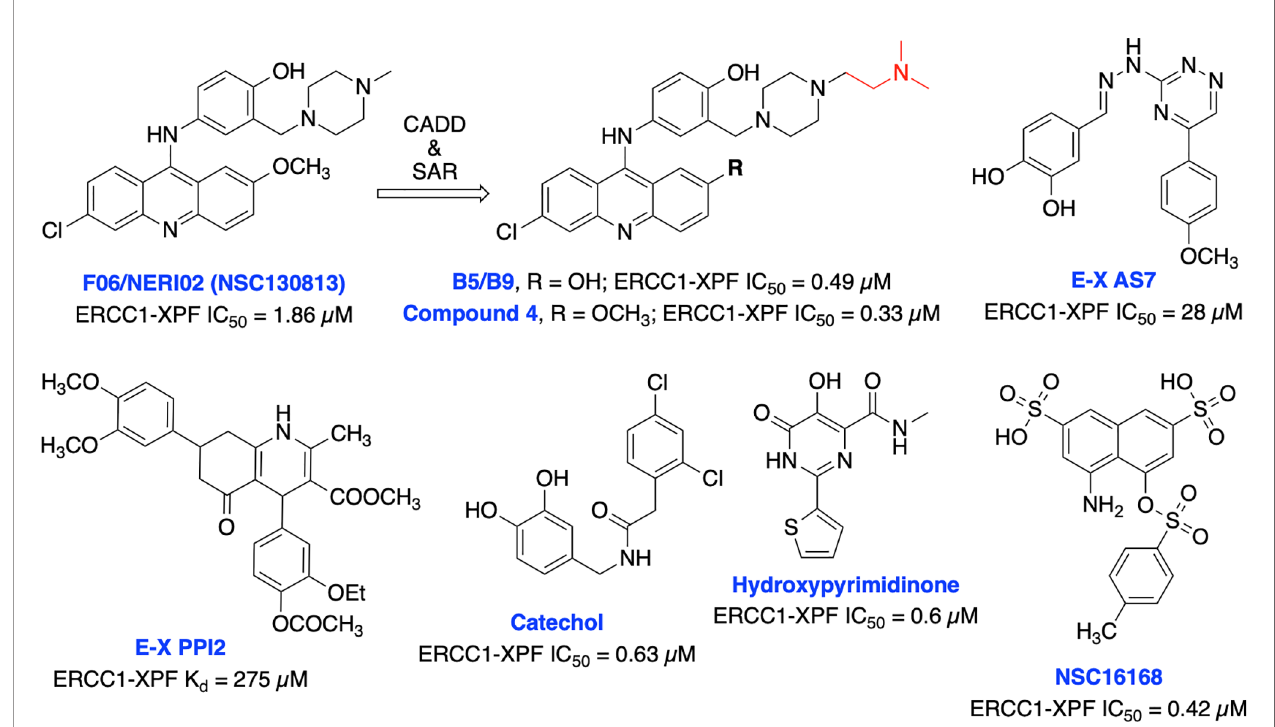
FIGURE 12 | Small molecule inhibitors targeting ERCC1-XPF with their respective Kd/IC50 values for inhibition of ERCC1-XPF endonuclease